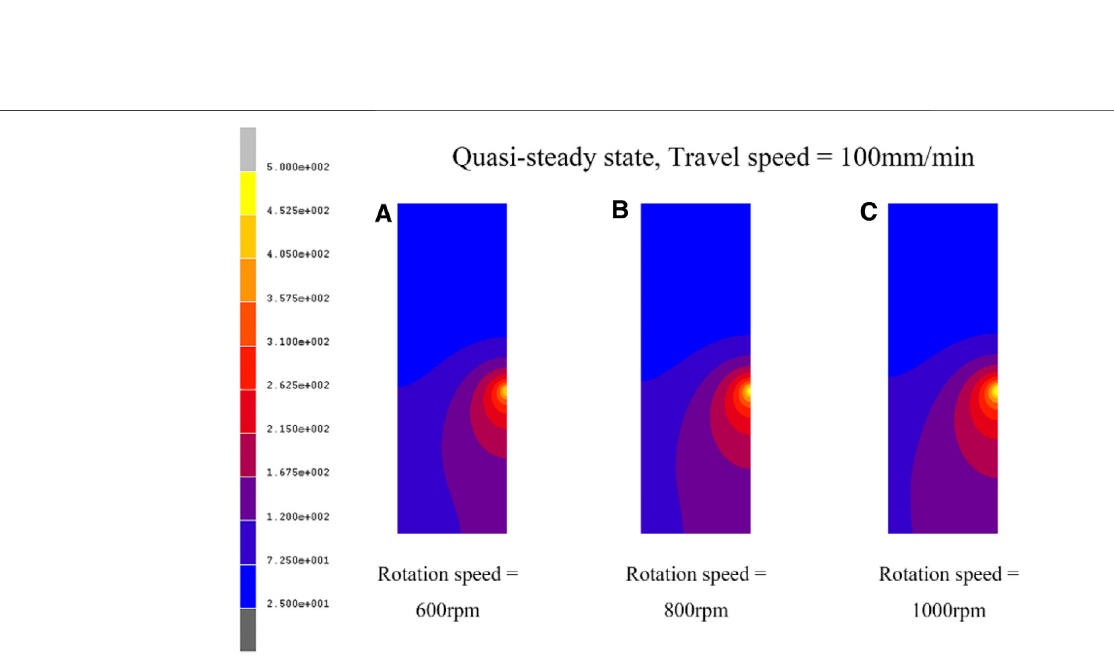
Frontiers in Materials |